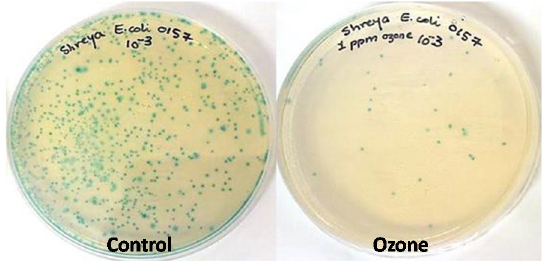
Figure 4. Colonies of E. coli O157:K88a on Tryptone Bile X-Glucuronide (TBX) agar recovered from leaves after being exposed to either “clean” air (control) or 1 ppm ozone concentration for 10